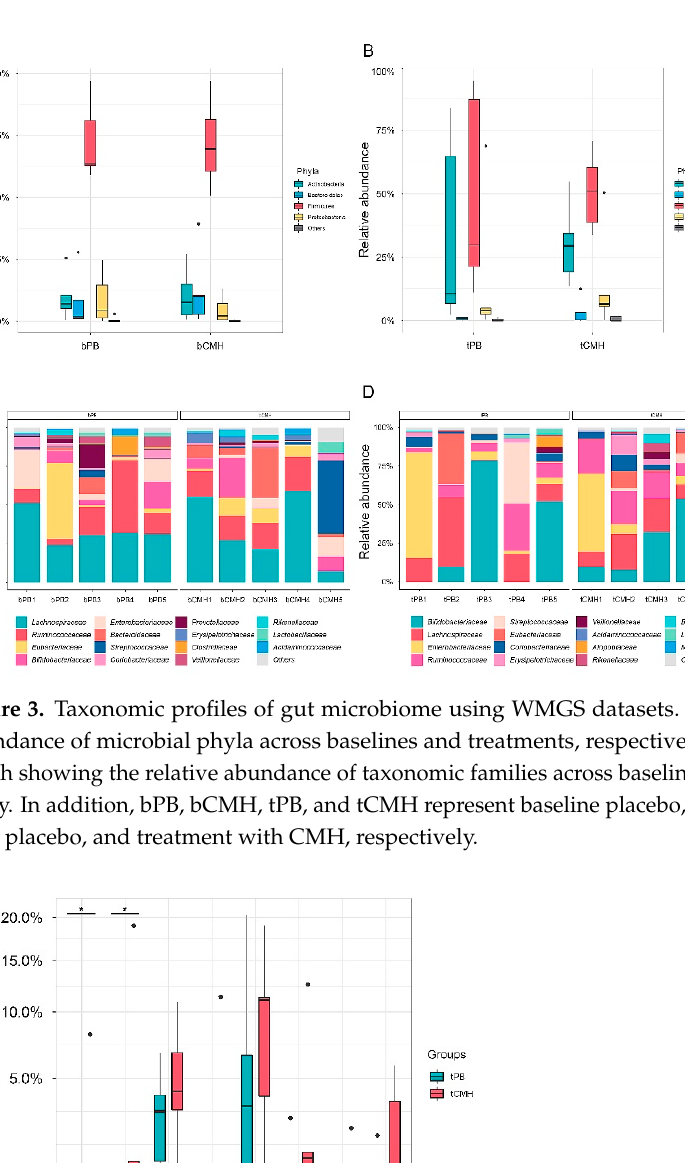
Figure 4. Comparison of relative abundance between tPB and tCMH on eight potential species, using WMGS datasets. For those marked with an asterisk (*), significant difference between tCMH and tPB groups is shown by different letters ( p -value <